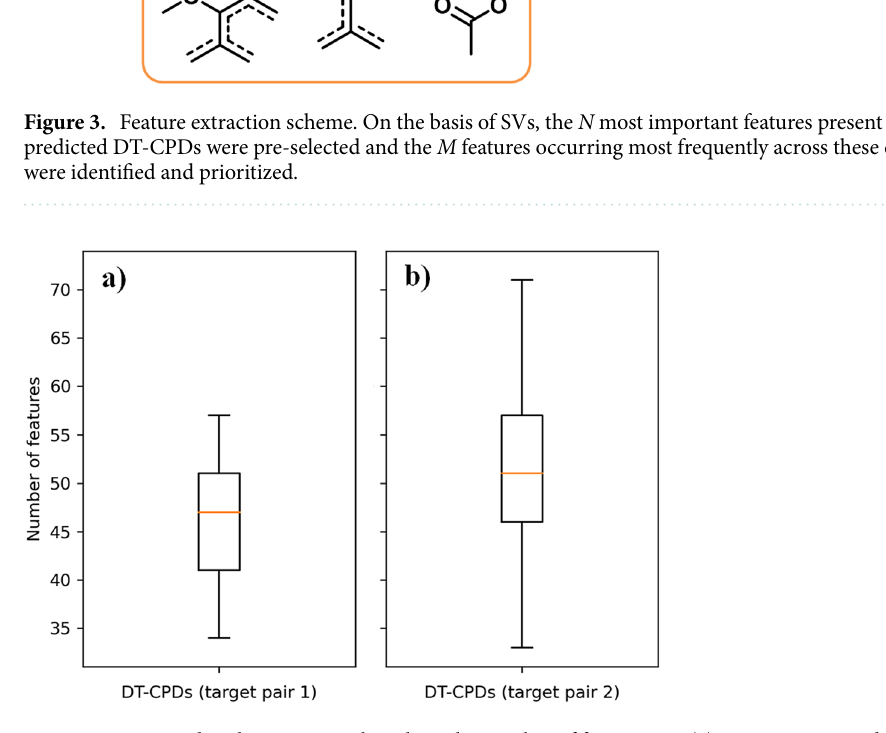
Figure 4. Feature distributions. Boxplots show the number of features per ( a ) MAOB-A2aR and ( b ) and MAOB-AChE